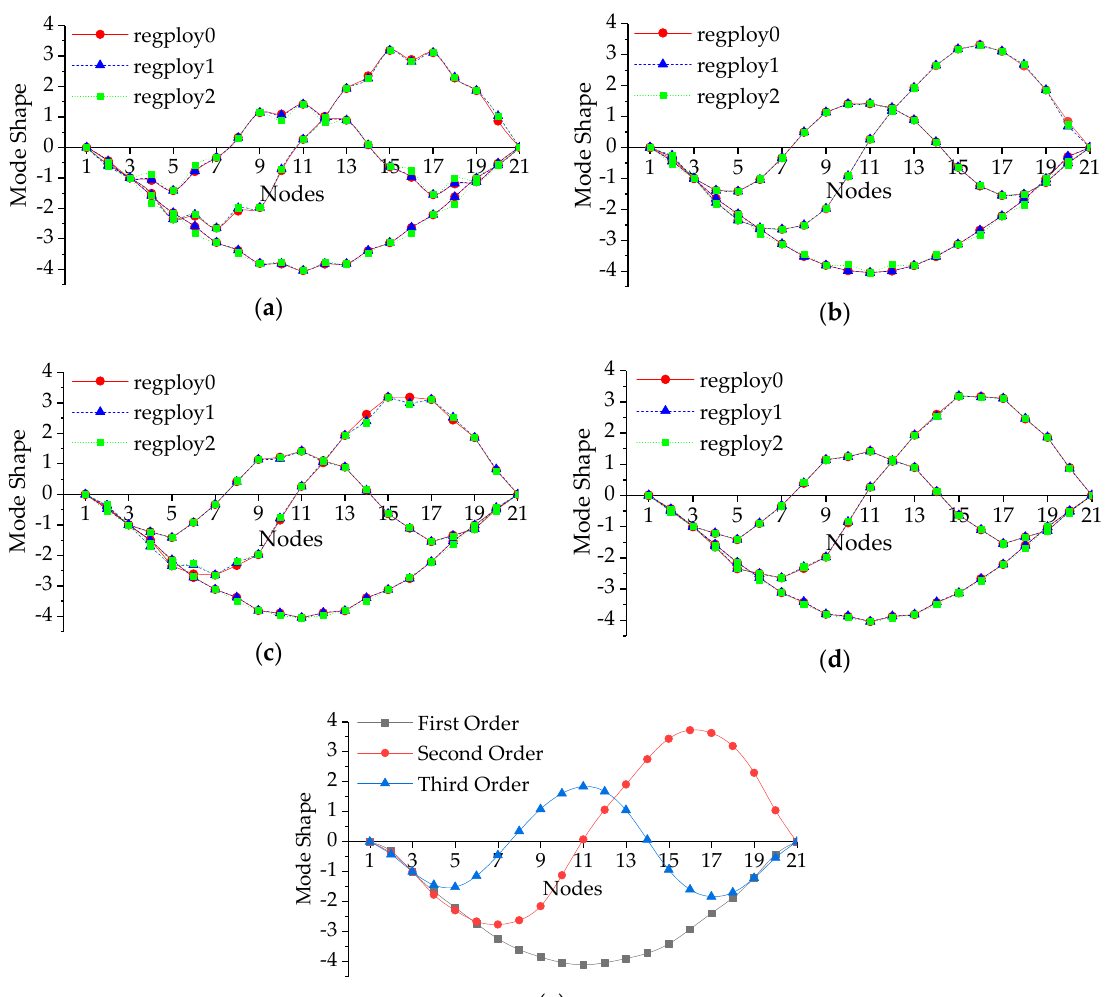
Figure 9. The first three vertical mode shapes simulated by different Kriging models and measured actually: ( a ) exponential model; ( b ) gaussian model; ( c ) linear model; ( d ) spherical model; ( e ) actual measured MSs. Table 3. Errors between actual measured and simulated MSs with 21 nodes Correlation Models